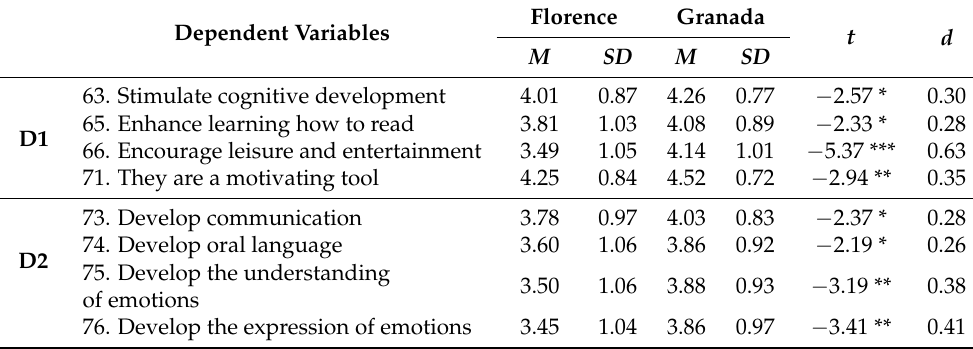
Table 6. Significant differences in the benefits and uses of apps as a function of city.